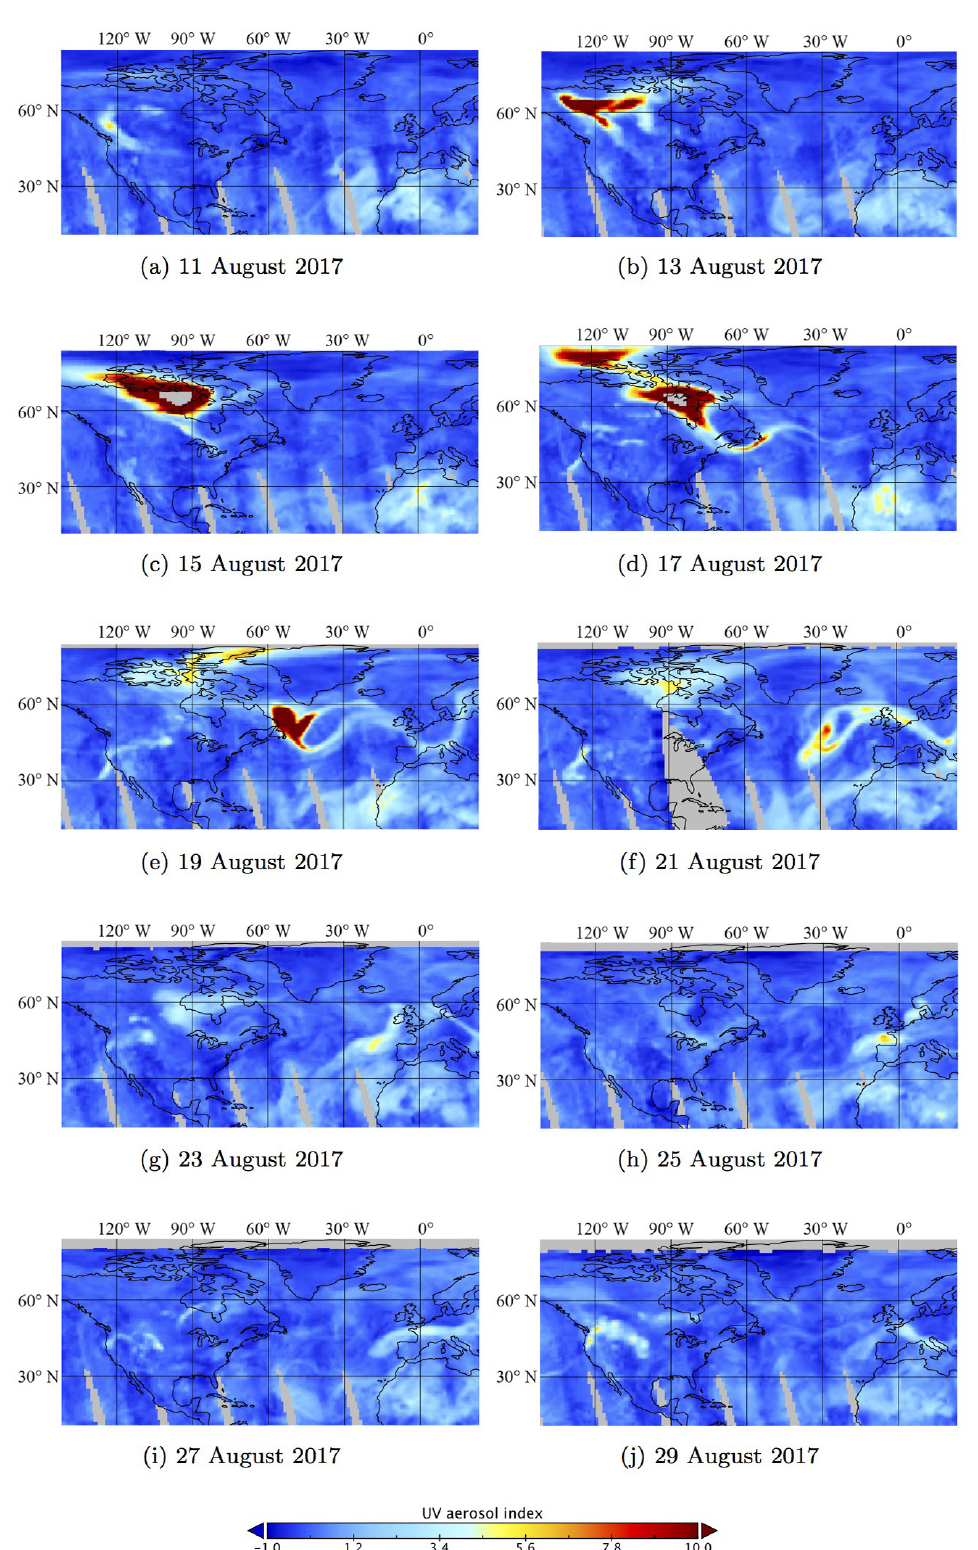
Figure 5. OMPS NM daily UVAI products from 11 to 29 August 2017. The results are plotted every 2 days. Grey indicates areas with no